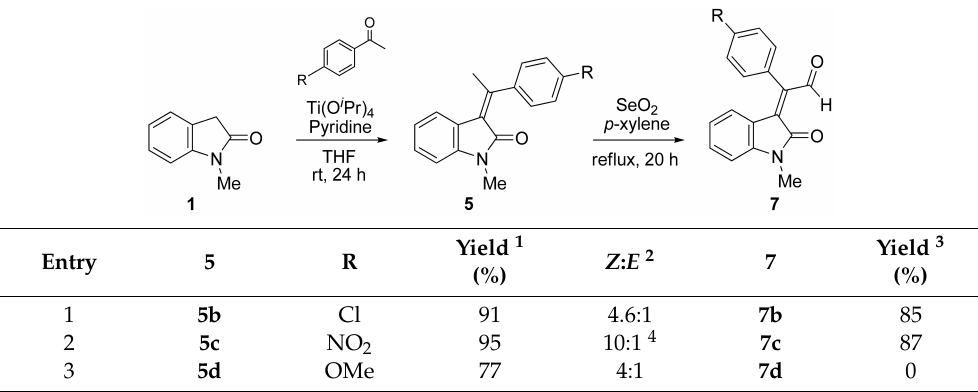
Table 1. Substrate scope for preparation of aldehyde 7 .